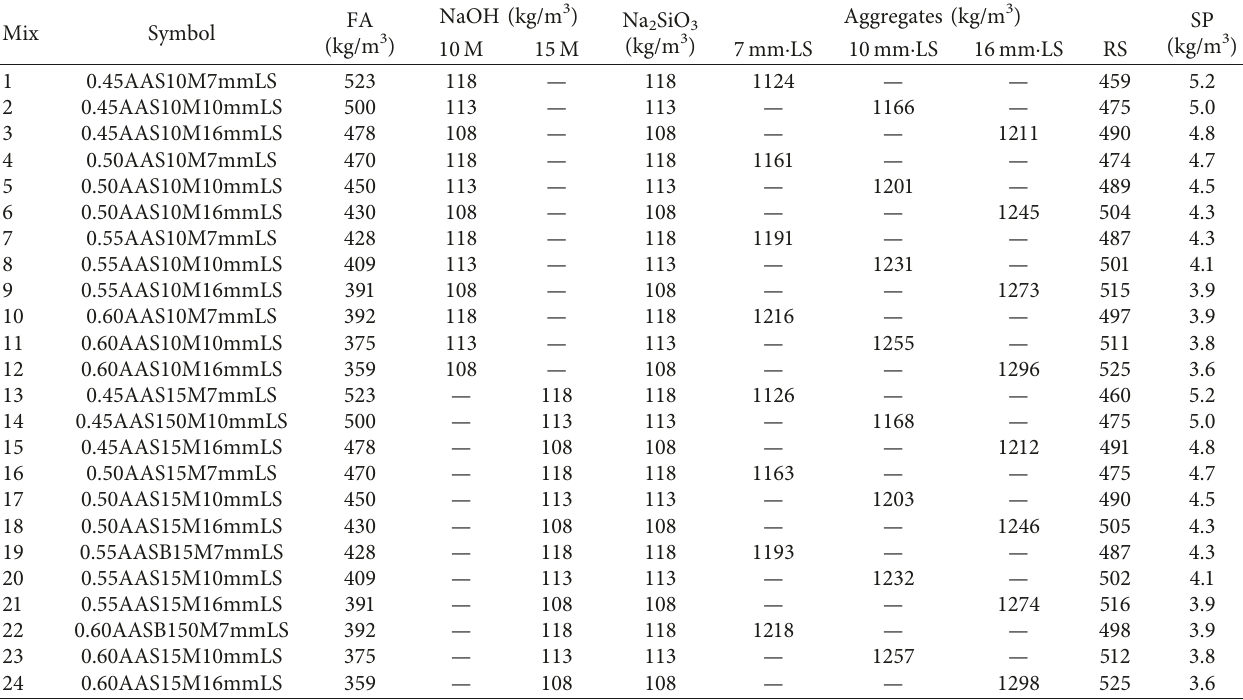
Table 5: Mix proportion used in this study based on the mix design